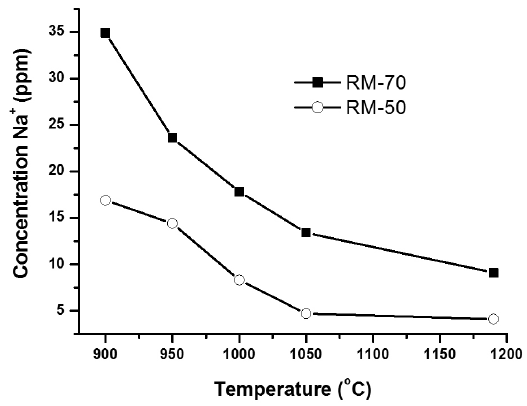
Figure 5. Leaching tests of ceramic bodies (RM-70 and